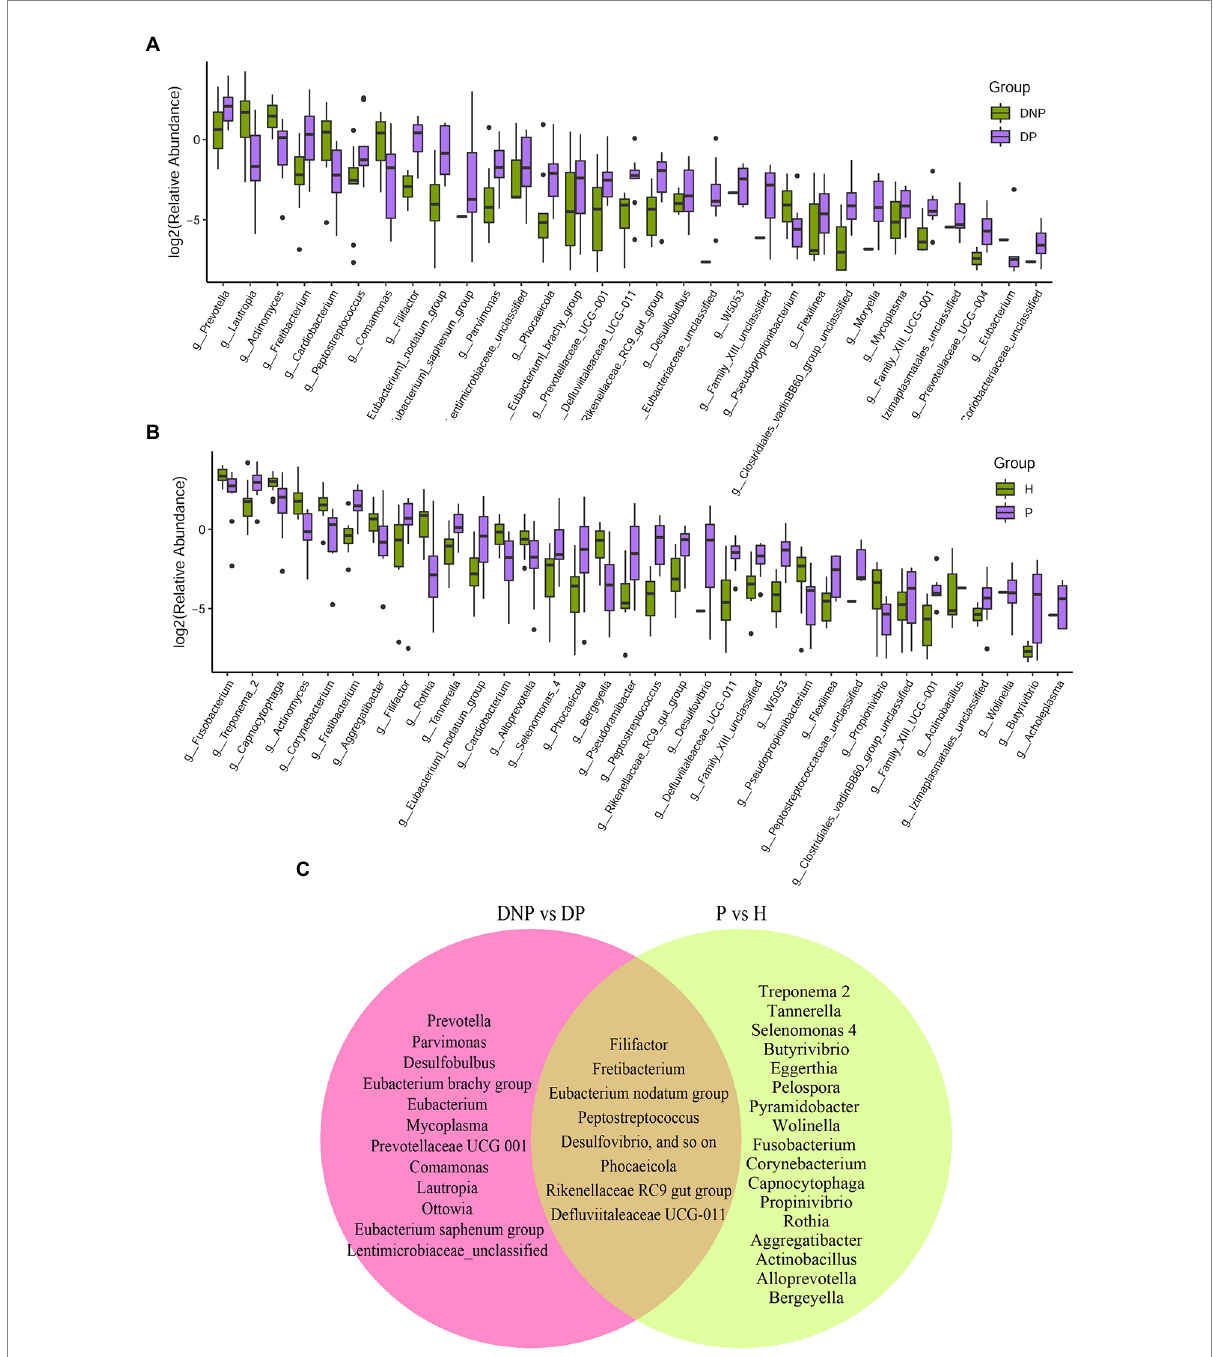
FIGURE 2 Distribution of differential genera between patients with/without T2DM. (A) Difference of relative abundances of subgingival bacterial genera between patients with DP or DNP; (B) Difference of relative abundances of subgingival bacterial genera between patients with P or H; (C) The 39 genera differentially abundant between the DP and DNP groups; 41 differentially abundant between the P and H groups. There were 23 genera which were both differential genus between the DP and DNP group, and between the P and H groups. Besides, 16 genera were differential genus between the DP and DNP group only; in addition, 18 genera were only differential genus between the P and H groups